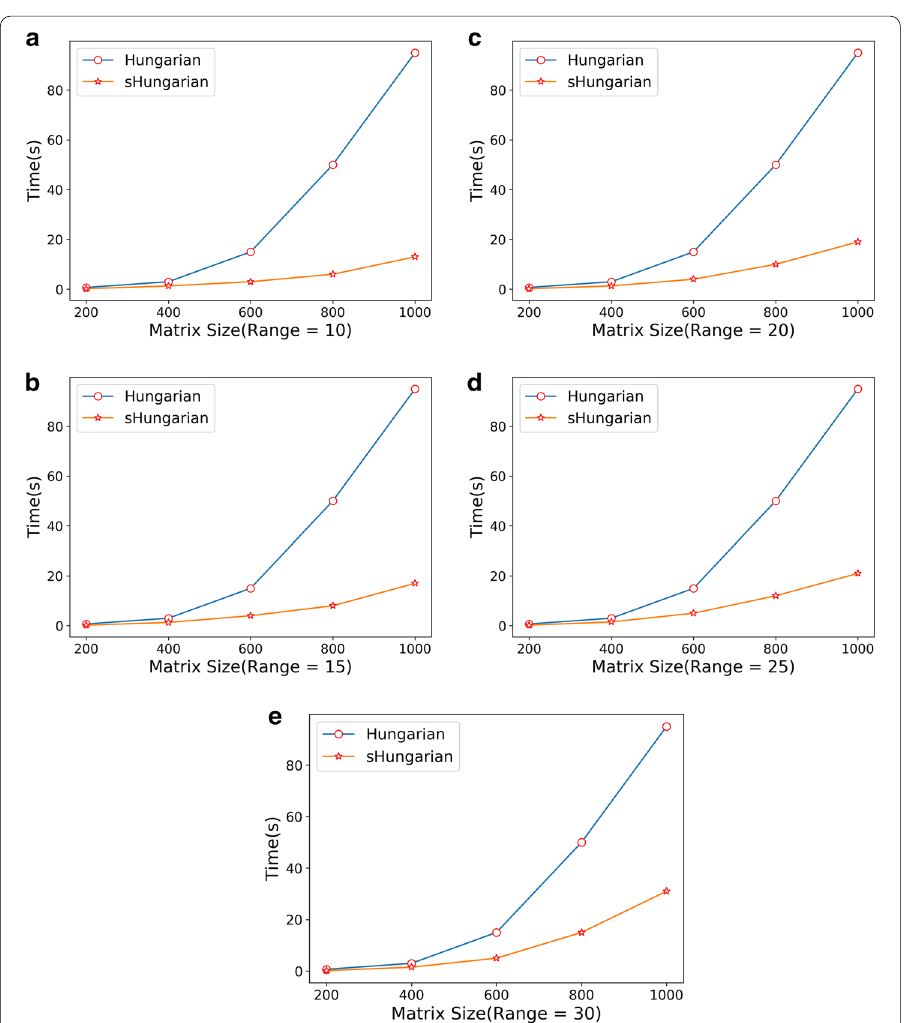
Fig. 4 Test of sHungarian algorithm